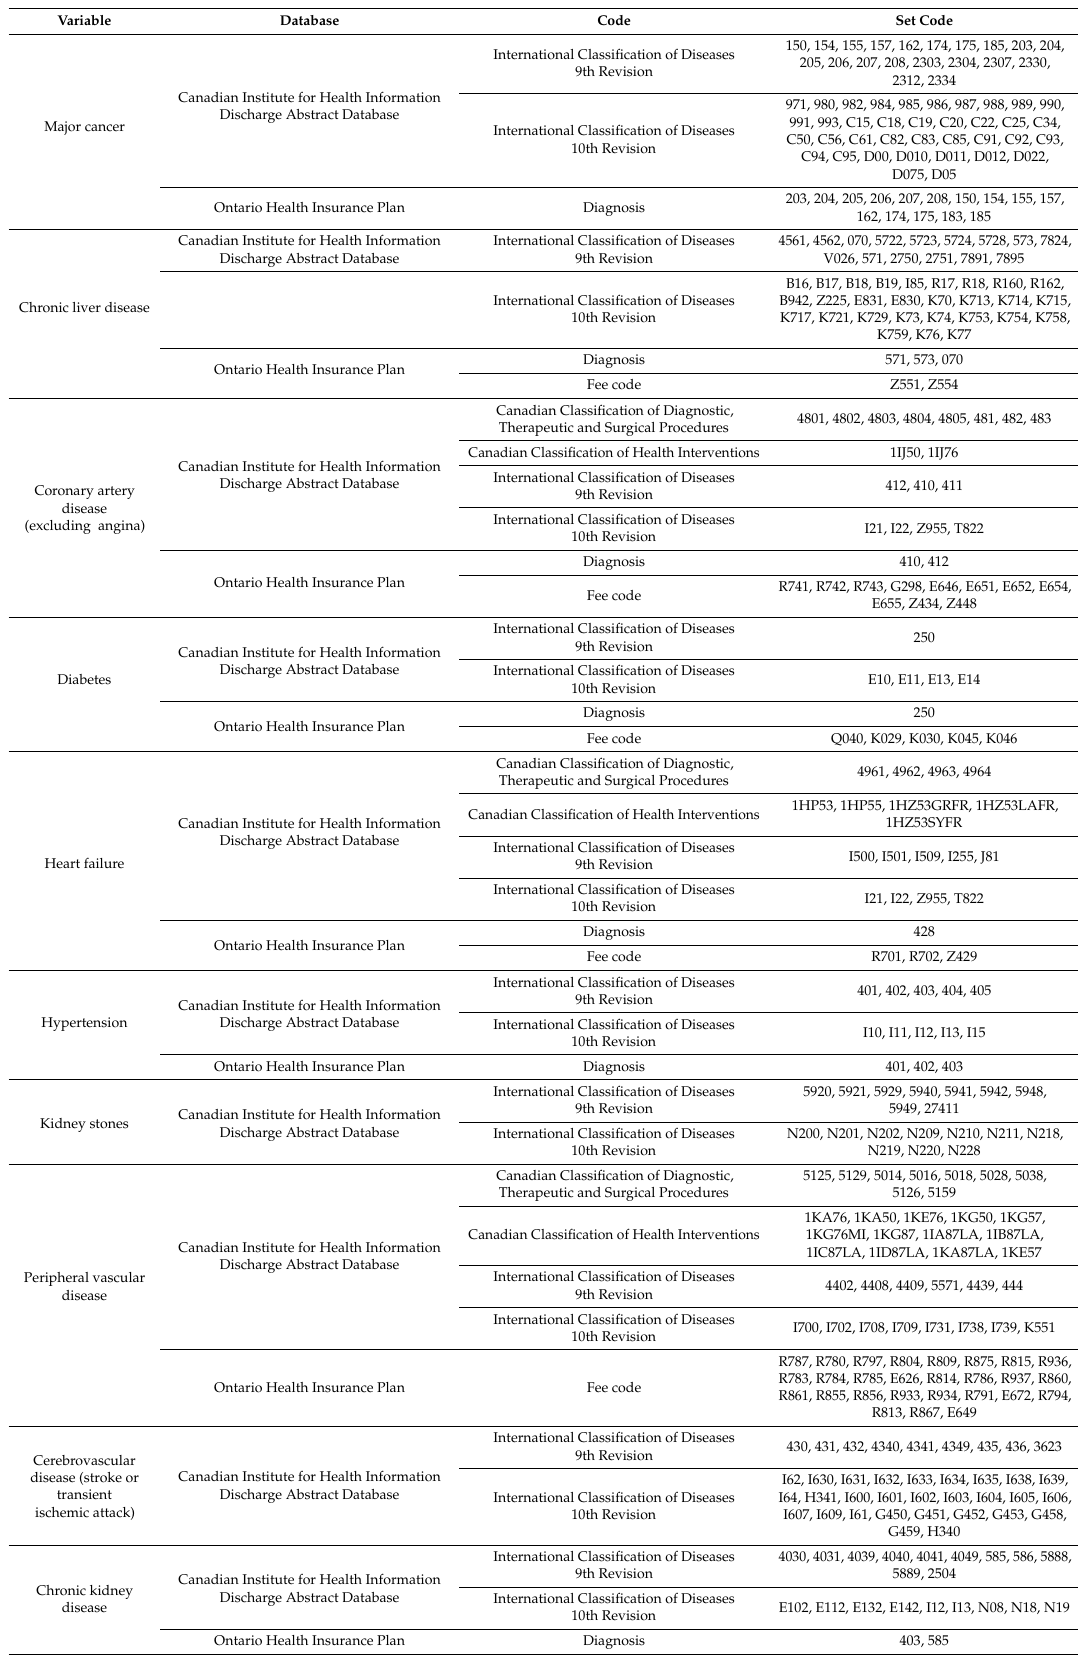
Table A2. Coding definitions for comorbid